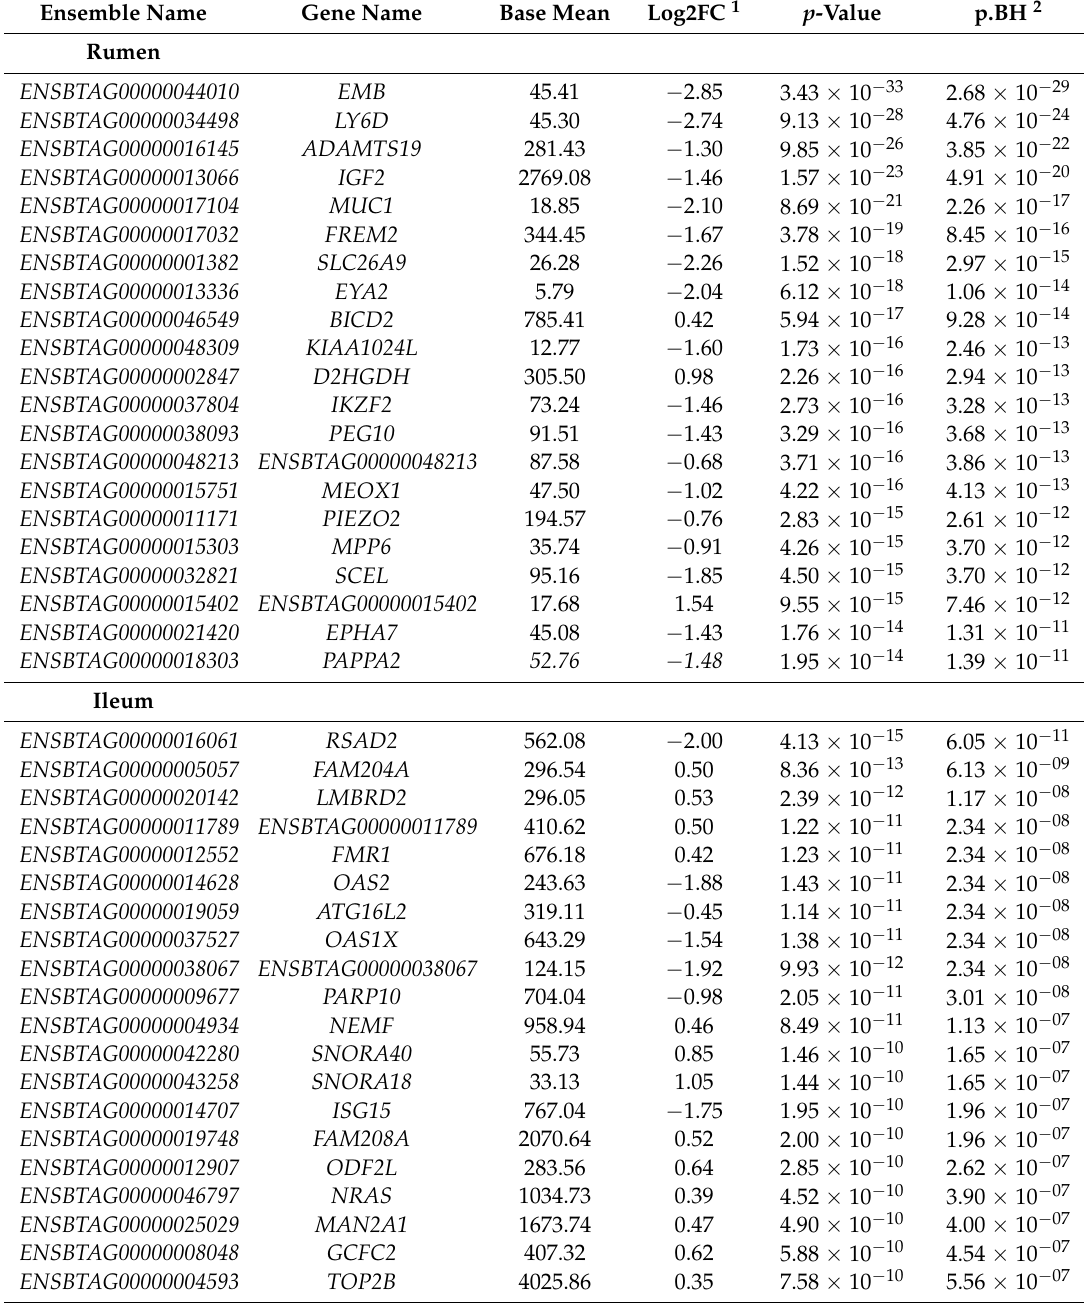
Table 1. Top significant differentially expressed genes between day 33 (pre-weaning) and day 96 (post-weaning) in rumen and ileum